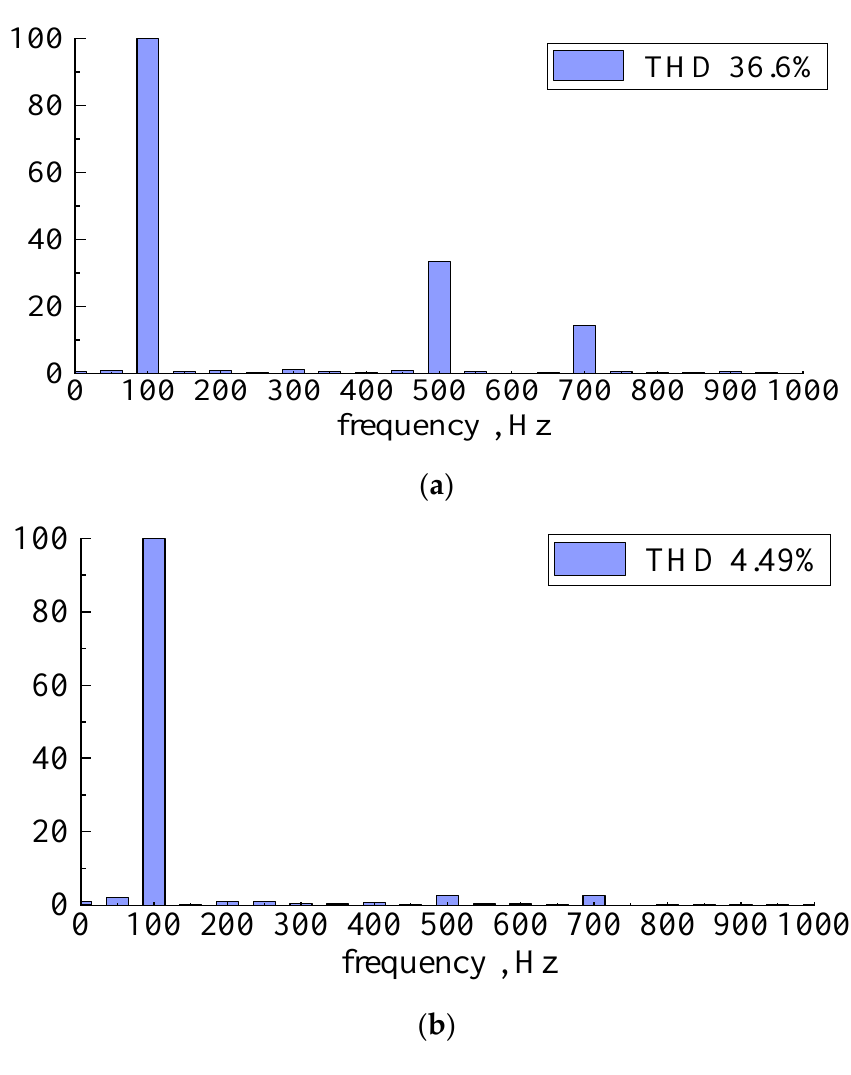
Figure 18. Current FFT analysis simulation diagram. ( a ) Traditional DTC current FFT analysis simulation diagram. ( b ) Low – harmonic DTC current FFT analysis simulation diagram.